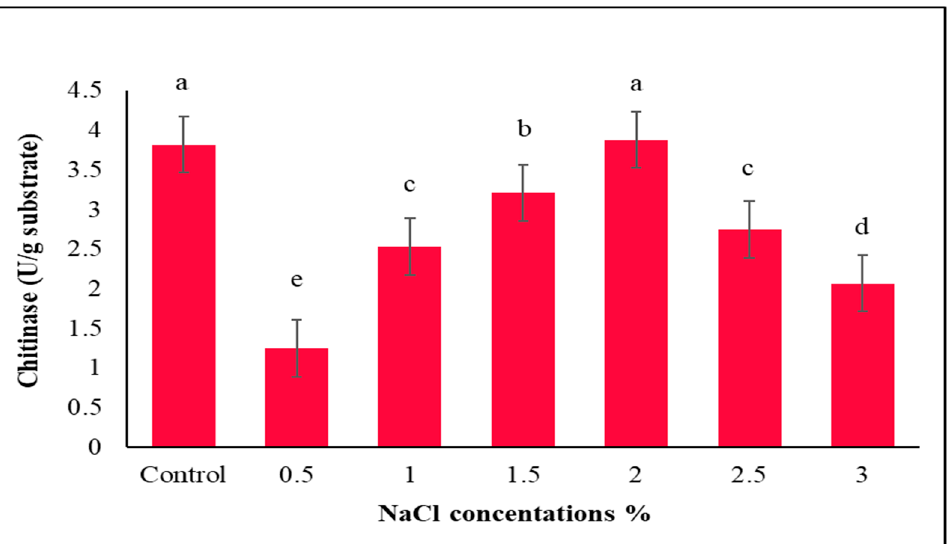
Figure 6. Effect of NaCl concentrations on the production of chitinase on SSF by T. funiculosus strain CBS 129594. The values are the means of three replicates with standard deviation (±SD). Mean values in each bar followed by a different lower-case-letter are significantly different according to Duncan’s multiple range tests at p ≤ 0.05.